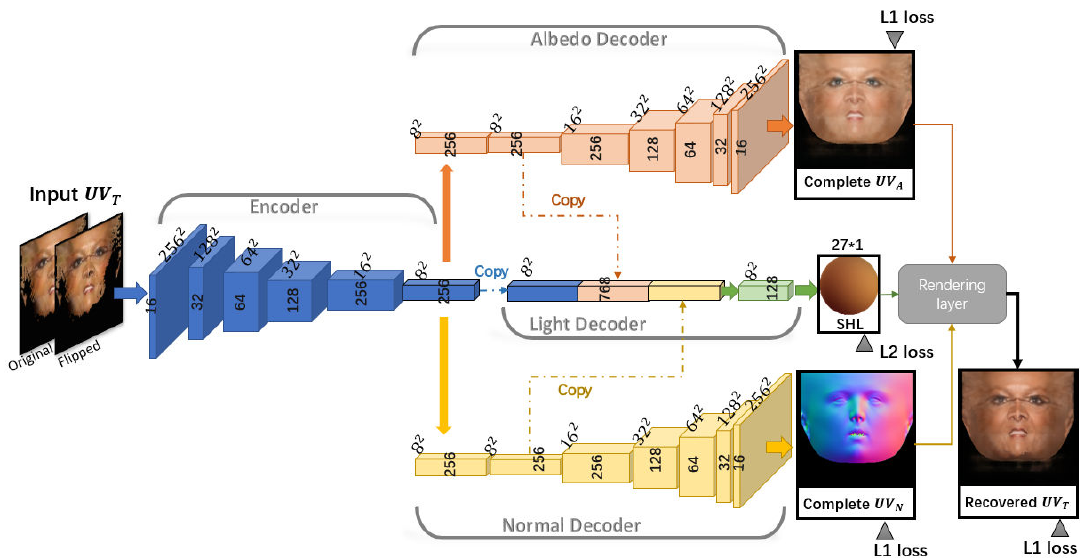
Figure 2. Pipeline of albedo